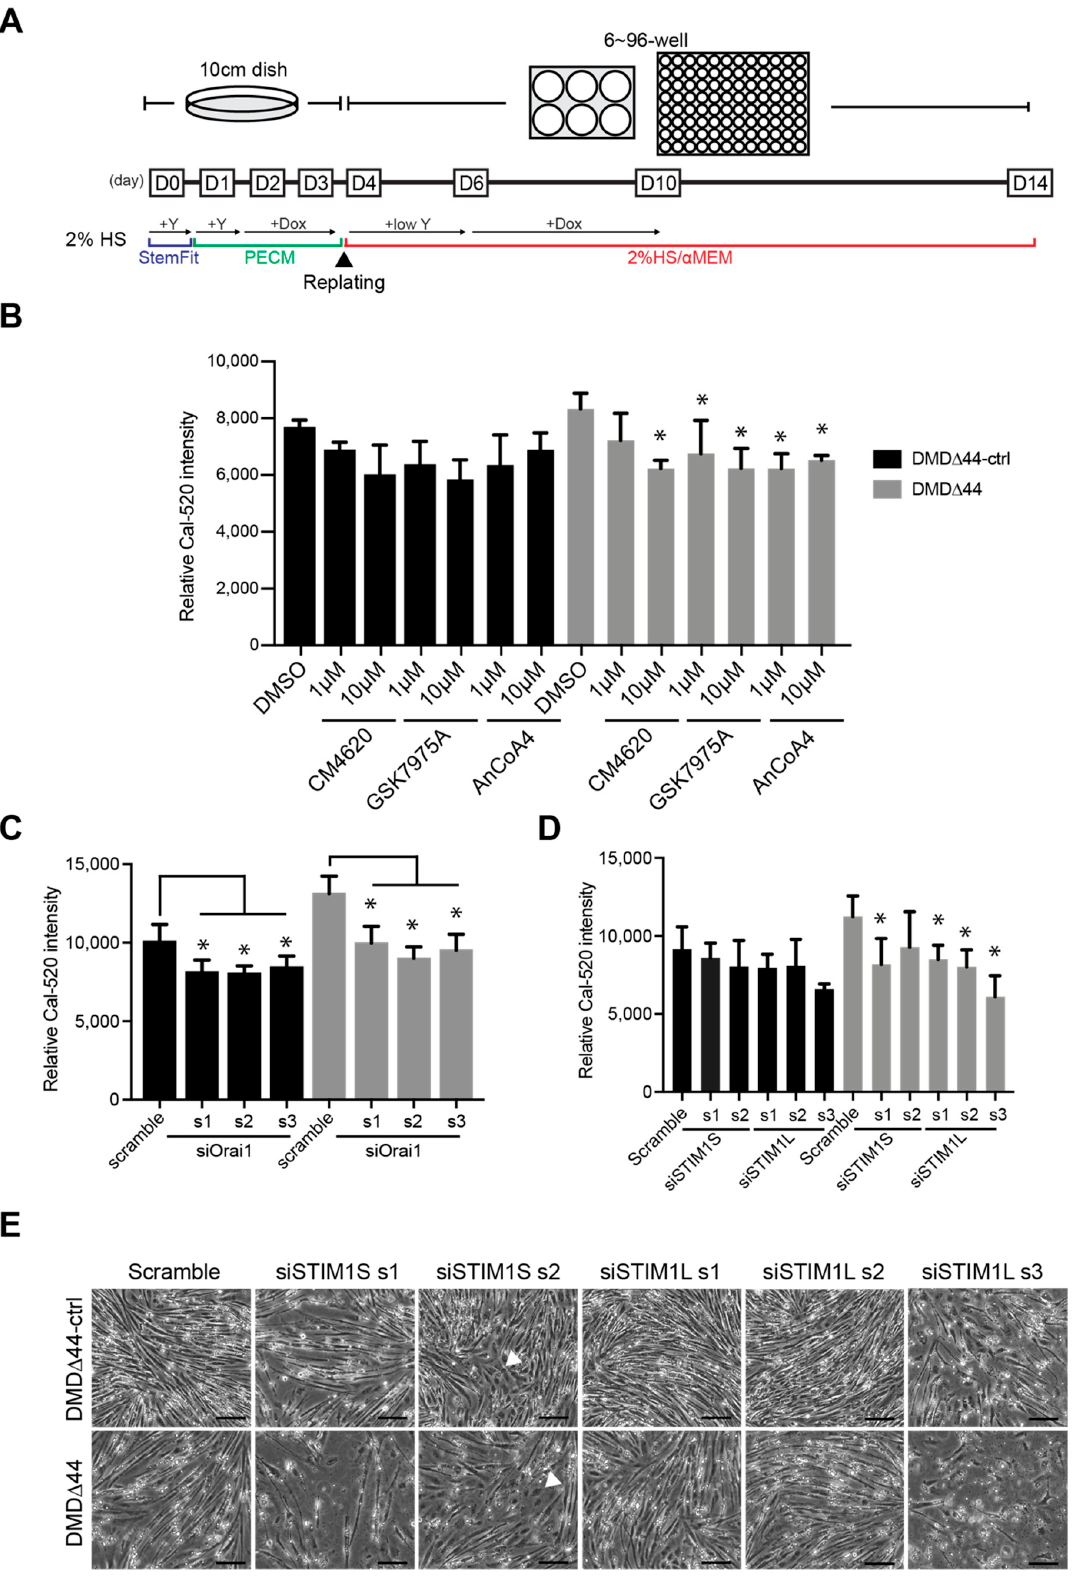
Figure 3. STIM1L–Orai1-regulated Ca 2+ overload in dystrophic myotubes. ( A ) Schematic diagram of the modified replat- ing method. Induced pluripotent stem cells (iPSCs; DMD ∆ 44 and DMD ∆ 44-ctrl) were myogenically pre-differentiated in primate ES cell medium (PECM) in the presence of doxycycline and re-plated on day 4 in the presence of low concentra- tions of Y-27632 and 2% horse serum media. ( B – D ) Relative Ca 2+ peak level using Orai1/STIM inhibitors, siRNAs targeting